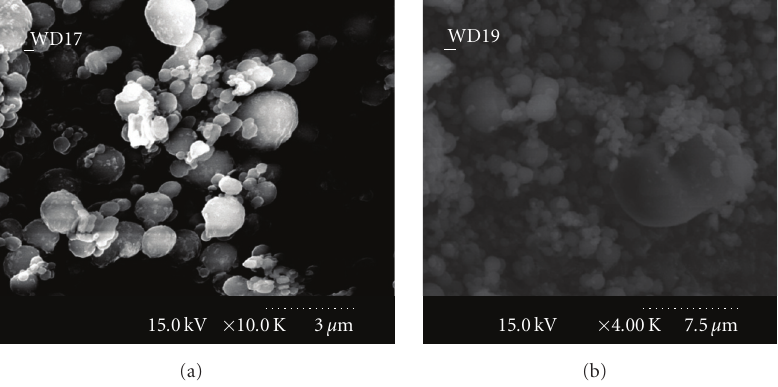
Figure 4: SEM images showing size and shapes of sample 2 (a) and sample 3